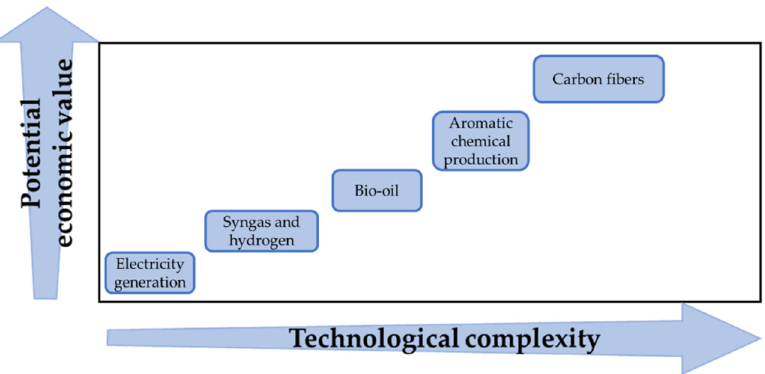
Figure 3. Applications of lignin as feedstock in terms of economic value vs. technological complex-